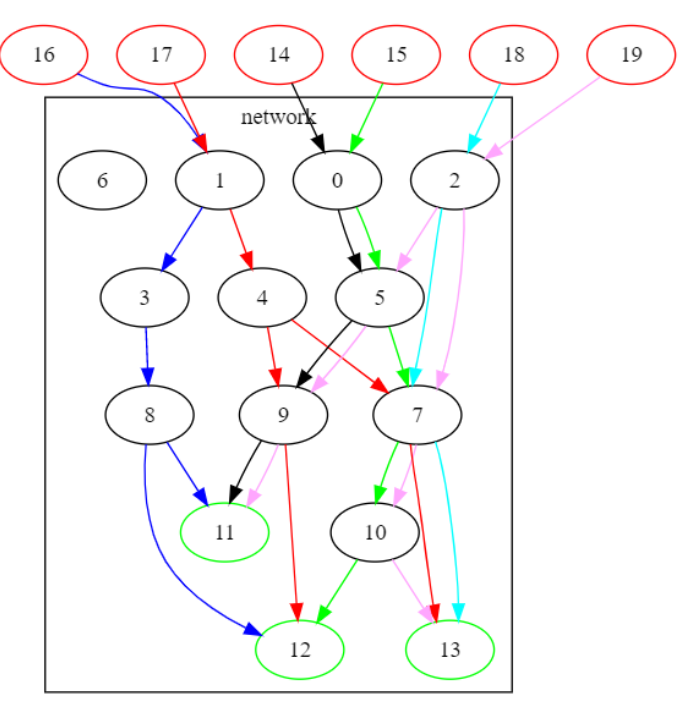
Figure 5. TinyInstance results.